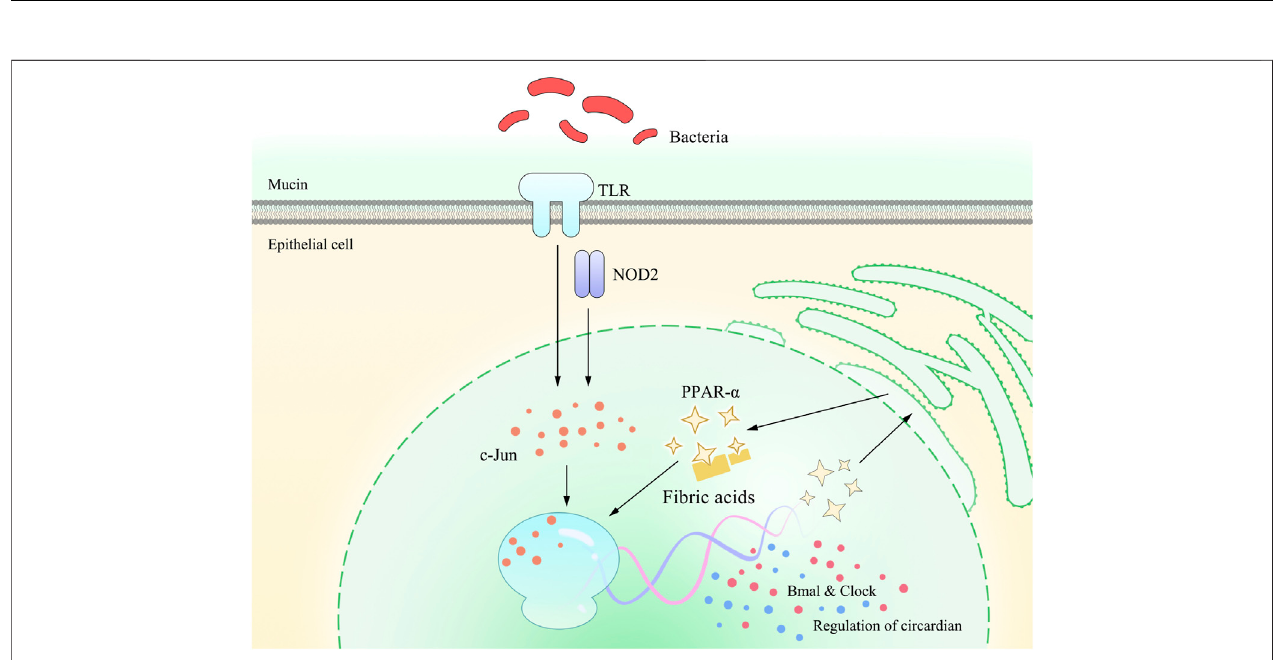
FIGURE 3 | Pattern diagram of PPAR- α involved in TLRs and NOD2 on gastrointestinal circadian rhythms or circadian clock. Studies have found that gastrointestinal circadian rhythms or circadian clock is affected by the gut fl ora, which is mainly sensed via TLRs and NOD2. This stimulation is further detected by the c-JunN-terminalkinase(JNK)andbindstotheenhancerheptamermotif,resultingintheactivationofPPAR- α and,inturn,activatingthetranscriptionofBmalandClock, which exert a direct impact on the regulation of gastrointestinal circadian rhythms or circadian